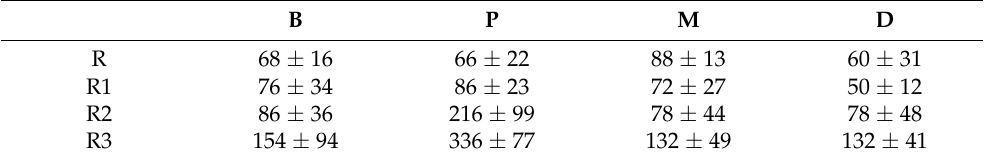
Table 2. Marginal fit results for virgin PLA and reused PLA models at each measurement point ( µ m).